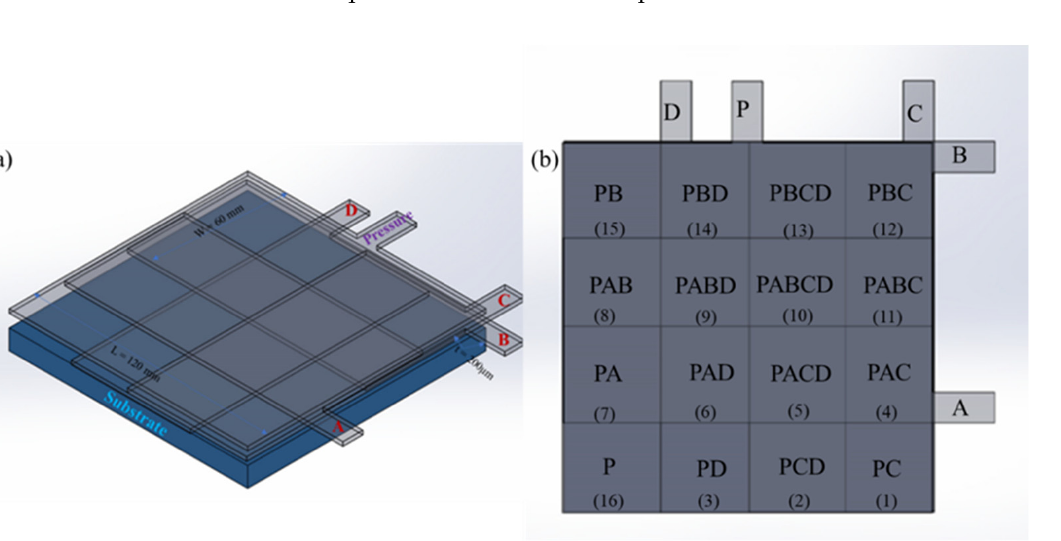
Figure 5. ( a ) A 3D view of the multimodal sensor showing the 5 sensor layers (P, A, B, C, and D); ( b ) a physical map of the 16 tactels.